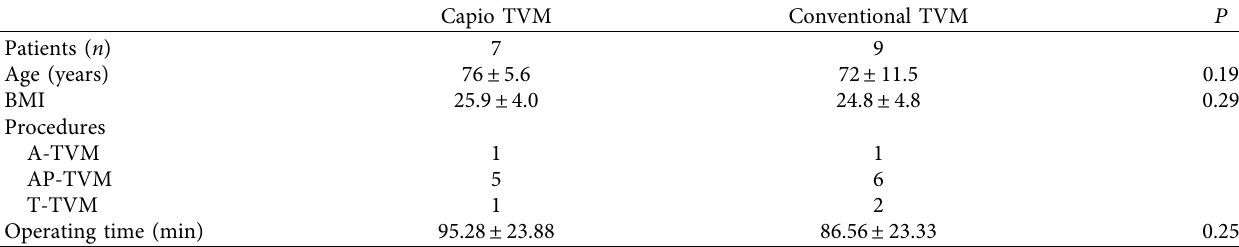
Table 1: Patient and surgical details.